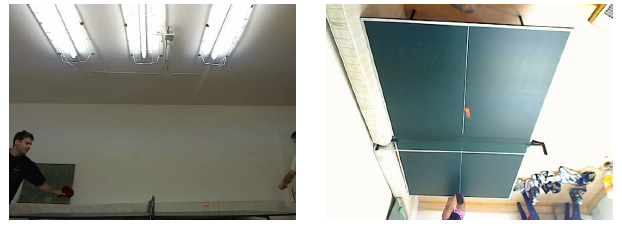
Figure 7. Pictures of a bounce - left: the main camera located on the side - right: the upper camera.